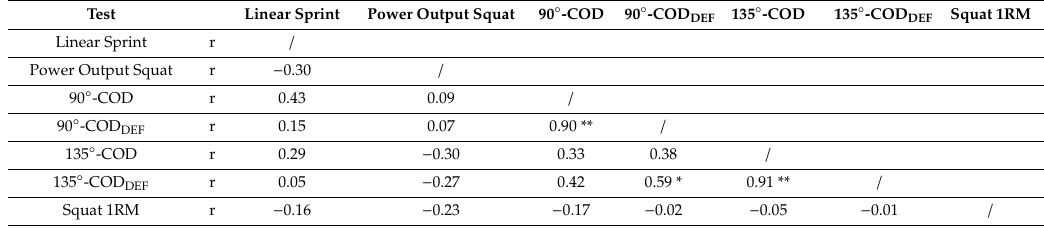
Table 2. Spearman’s rank order correlations between all measured